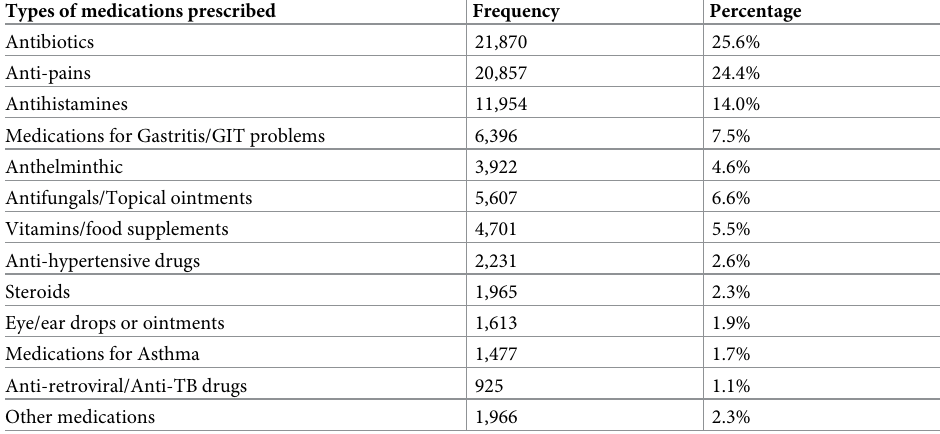
Table 4. Types and frequency of medication prescriptions at the study clinics between April 1 and December 27, 2016, in Nairobi, Kenya (N = 85,484).